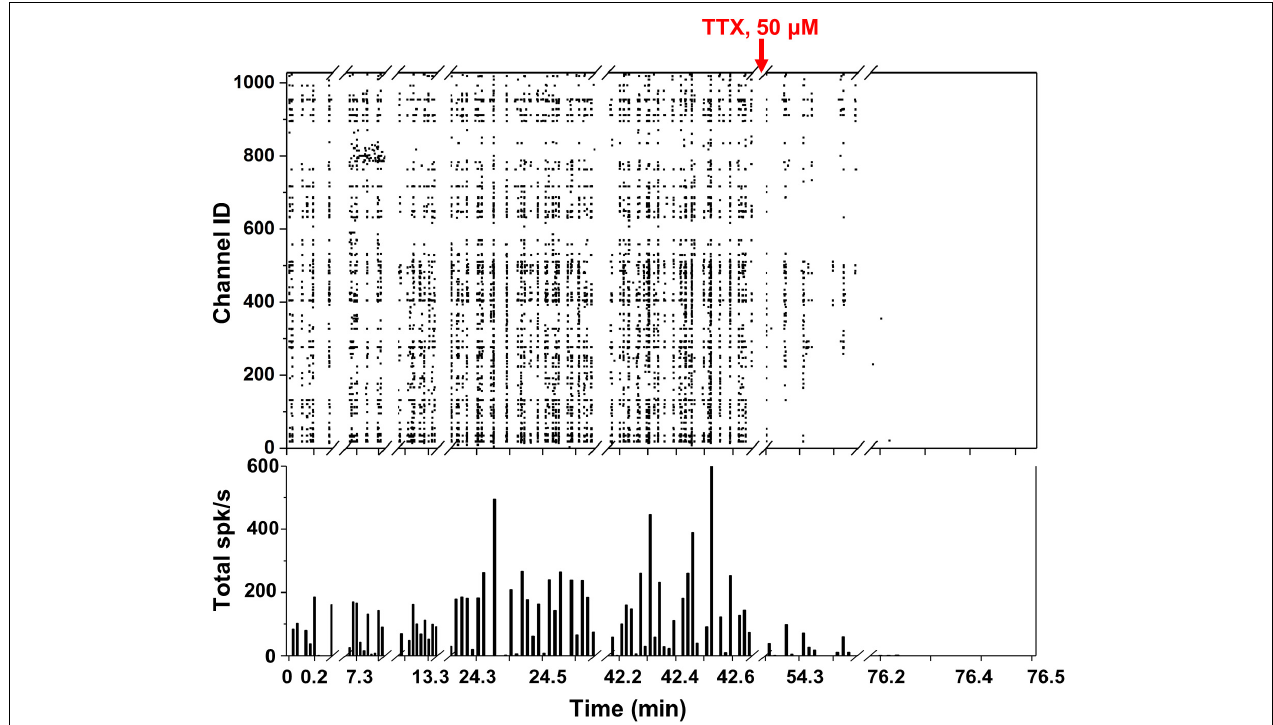
FIGURE 4 | Spontaneous network activity and TTX experiment. (Top) Raster plot showing the network spiking activity ( y axis) of 1024 electrodes in time ( x axis) over more than 1 h. Each black square corresponds to an identified spike. (Bottom) Total spikes/s bar plot with 1 bin = 1 s.